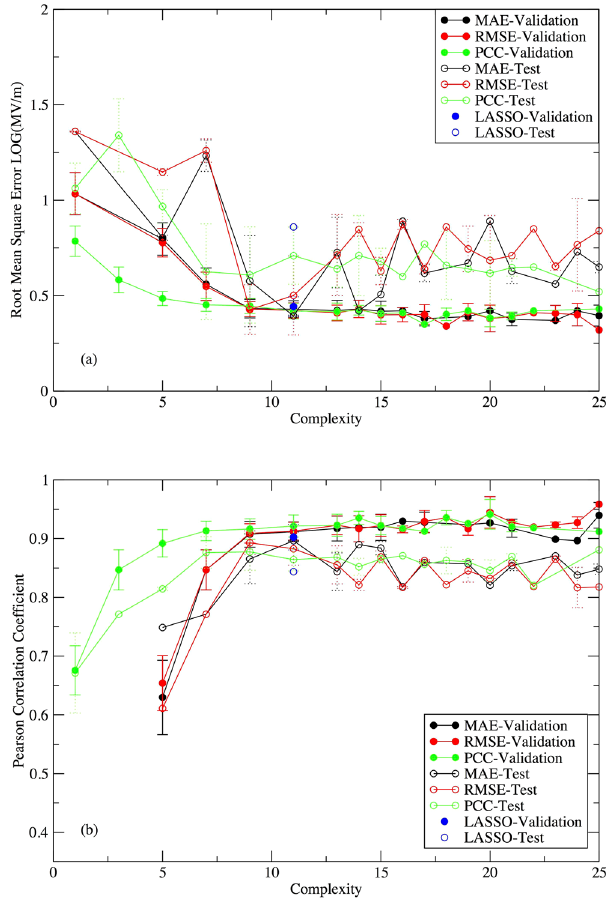
Figure 4. Average ( a ) RMSE and ( b ) PCC performance of models on validation and test sets by MAE, RMSE, PCC optimizations compared with the LASSO solution. The error bar is the calculated standard deviation from averaging over 16 parallel Eureqa